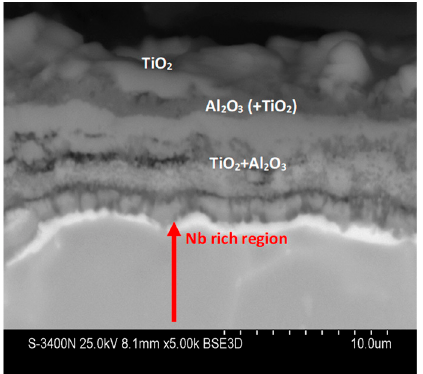
Figure 25. SEM-BSE images of Ti–46Al–7Nb–0.7Cr–0.1Si–0.2Ni alloy after cyclic oxidation.